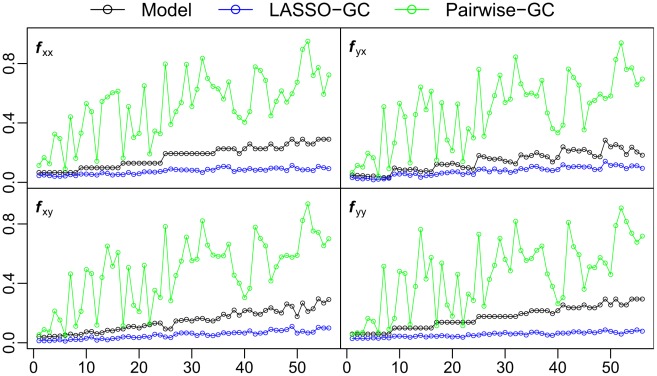
Comparison of LASSO-GC and pairwise-GC methods in recovering the f summary statistic.The fraction of significant b coefficients (f summary statistic) in each submatrix, computed directly from the simulation model, is compared with the f statistic estimated by the LASSO-GC and pairwise-GC methods. The estimated LASSO-GC f statistic more closely matches the f statistic of the model across simulation models than does the estimated pairwise-GC f statistic. The horizontal axis is arranged the same way as in Figure 2. The example shown in Figure 3 is from the 28th model.